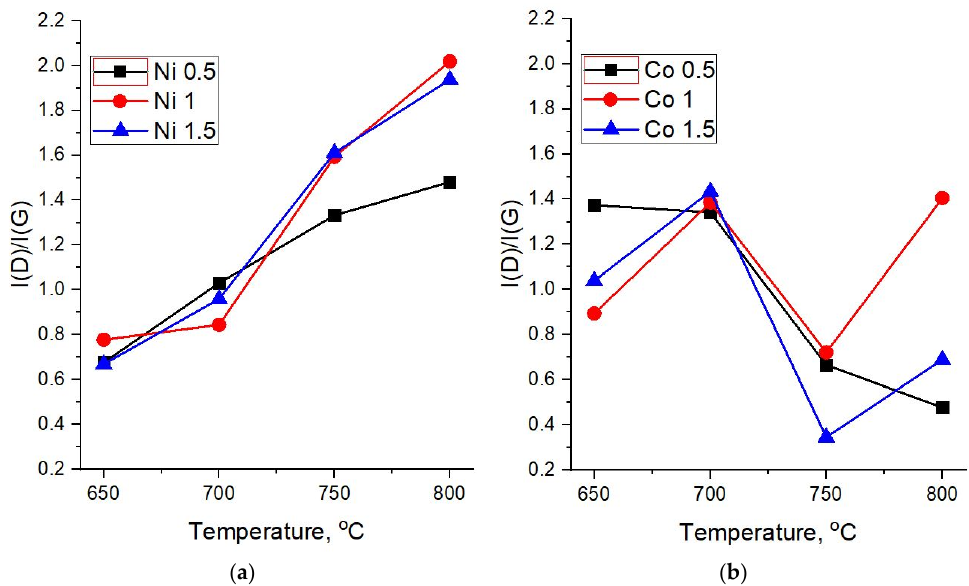
Figure 7. Dependence of the ratio of intensities I(D)/I(G) on the synthesis temperature of MWCNTs. ( a ) Ni and ( b ) Co catalysts.